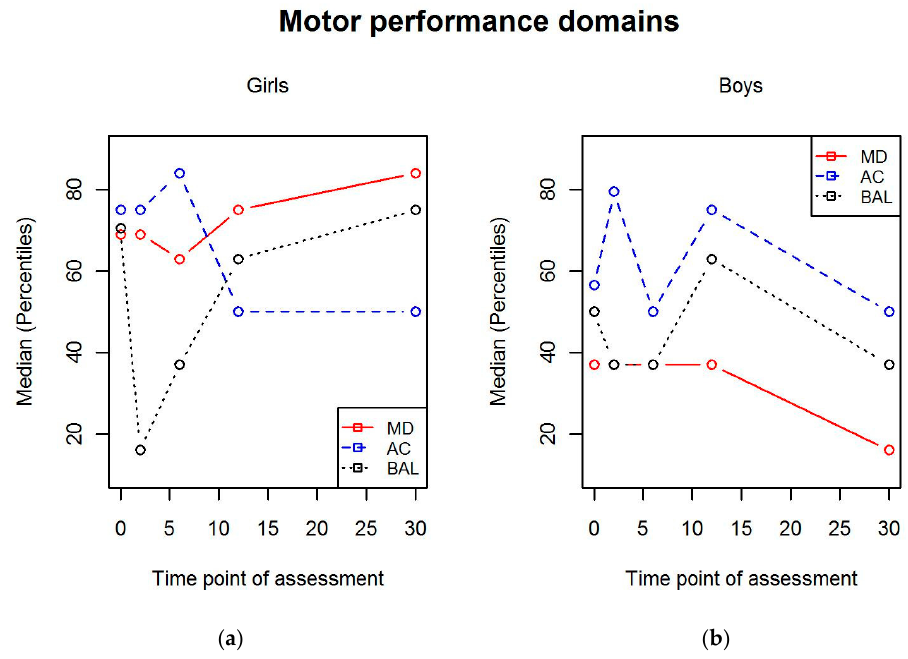
Figure 5. Scores for motor performance domains in ( a ) girls and ( b ) boys. MD = manual dexterity; AC = aiming and catching; BAL = balance.